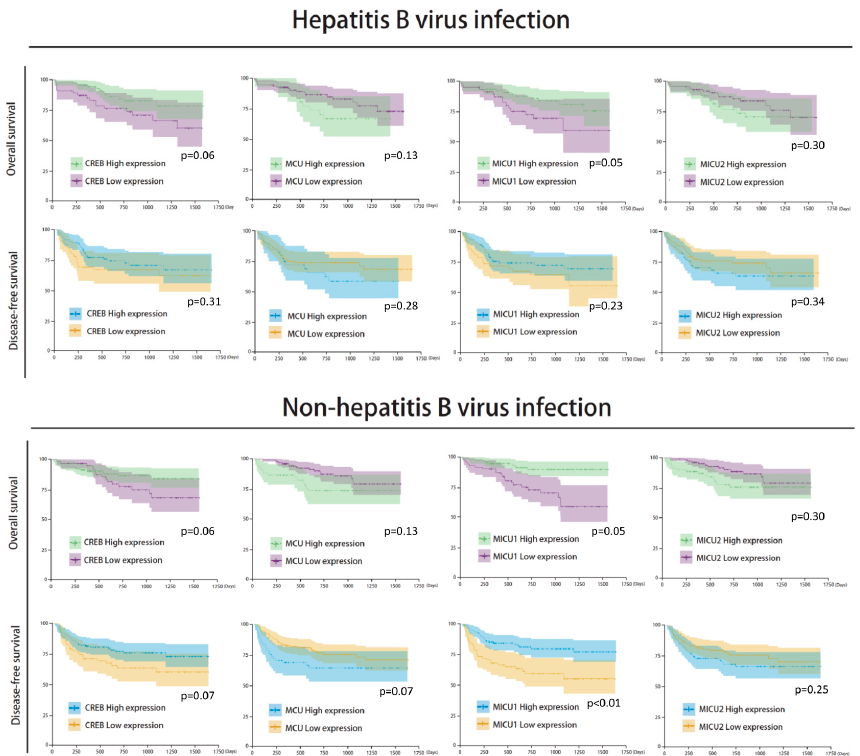
Figure 7. Kaplan–Meier analysis of four mitochondria gene expression in HBV / non-HBV infection subgroup analysis.